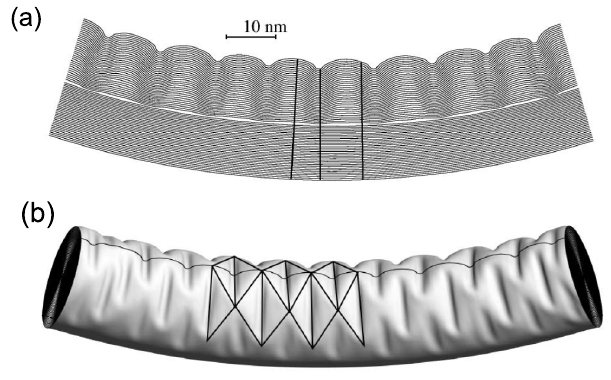
Figure 14. Rippling of a 34-walled carbon nanotube: ( a ) longitudinal section of the central part of the simulated nanotube; and ( b ) the morphology of the rippled MWNT reminiscent of the Yoshimura pattern. Highlighted are the ridges and furrows, as well as the trace of the longitudinal section. Reprinted from Reference